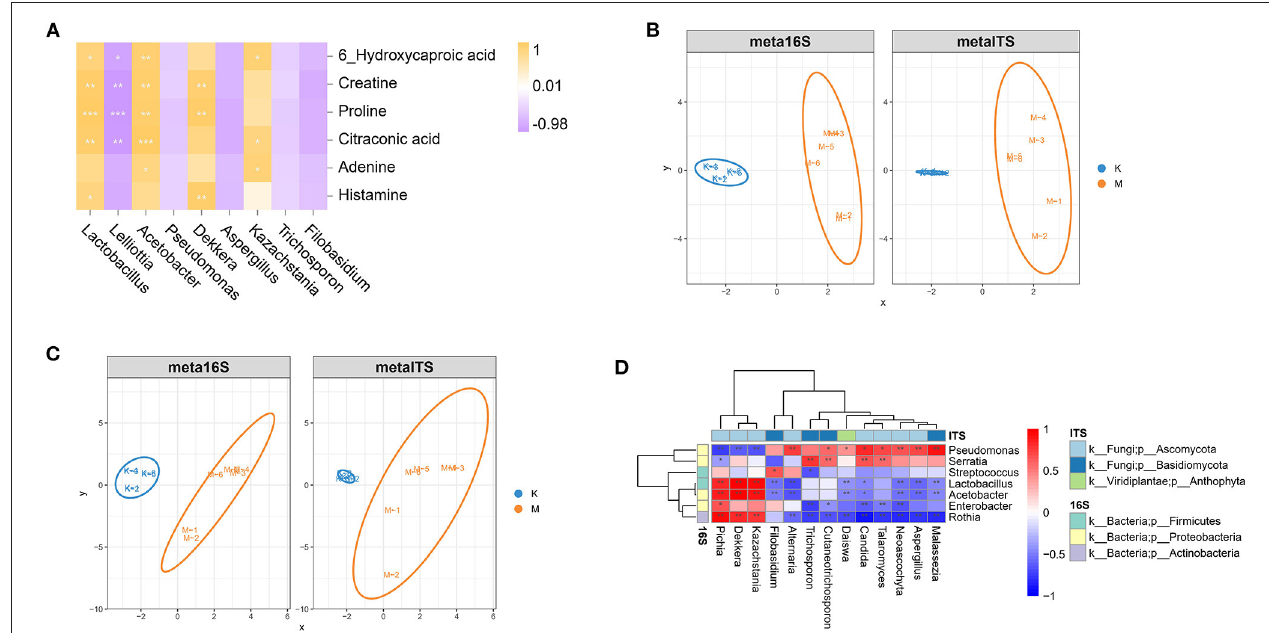
FIGURE 7 | Sparse partial least squares (SPLS) and SPARCC analysis among species. (A) Correlation analysis of different bacteria and different compounds before and after mare’s milk fermentation. (B,C) sPLS analyses at the family and genus levels, respectively. (D) Heat map of the SPARCC correlation coefficient at the bacterial and fungal genus